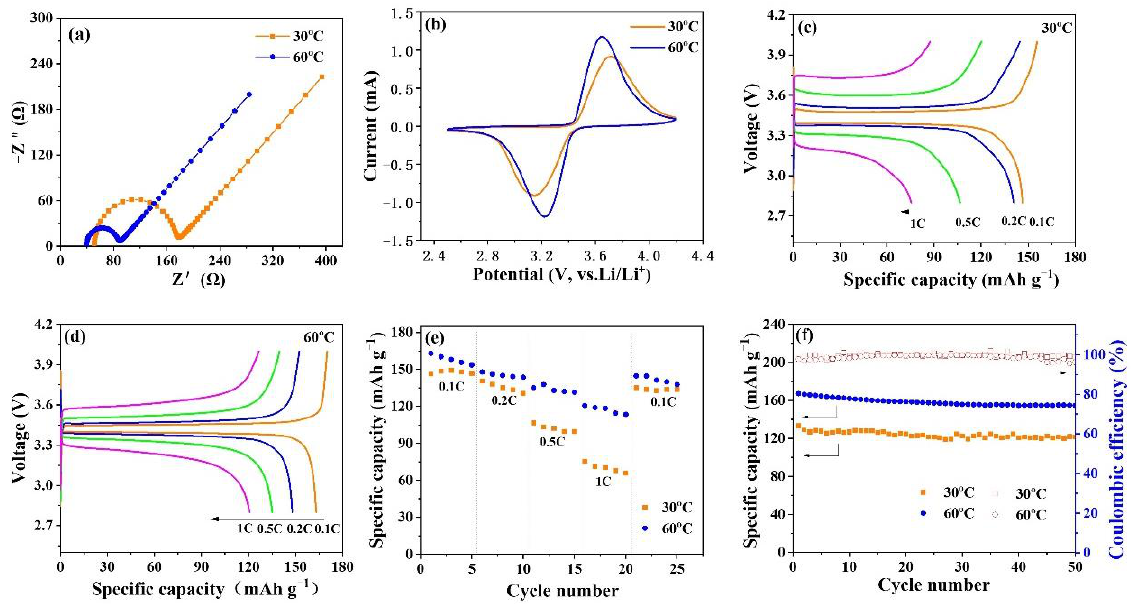
Figure 7. ( a ) Impedance diagram, ( b ) CV curves, ( c , d ) initial charge – discharge curves, ( e ) rate capability and ( f ) cycling life of LFP/CSE/Li battery at 30 and 60 °C.